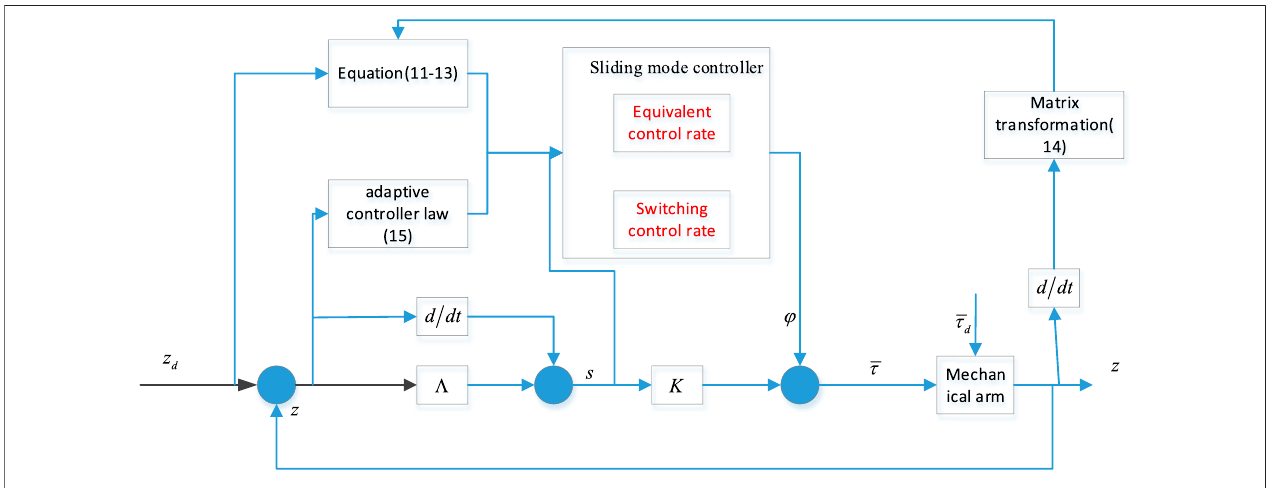
FIGURE 5 | The structure fi gure of adaptive sliding mode